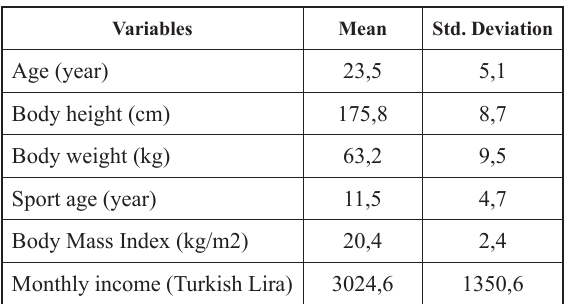
Table 1. Demographic findings of